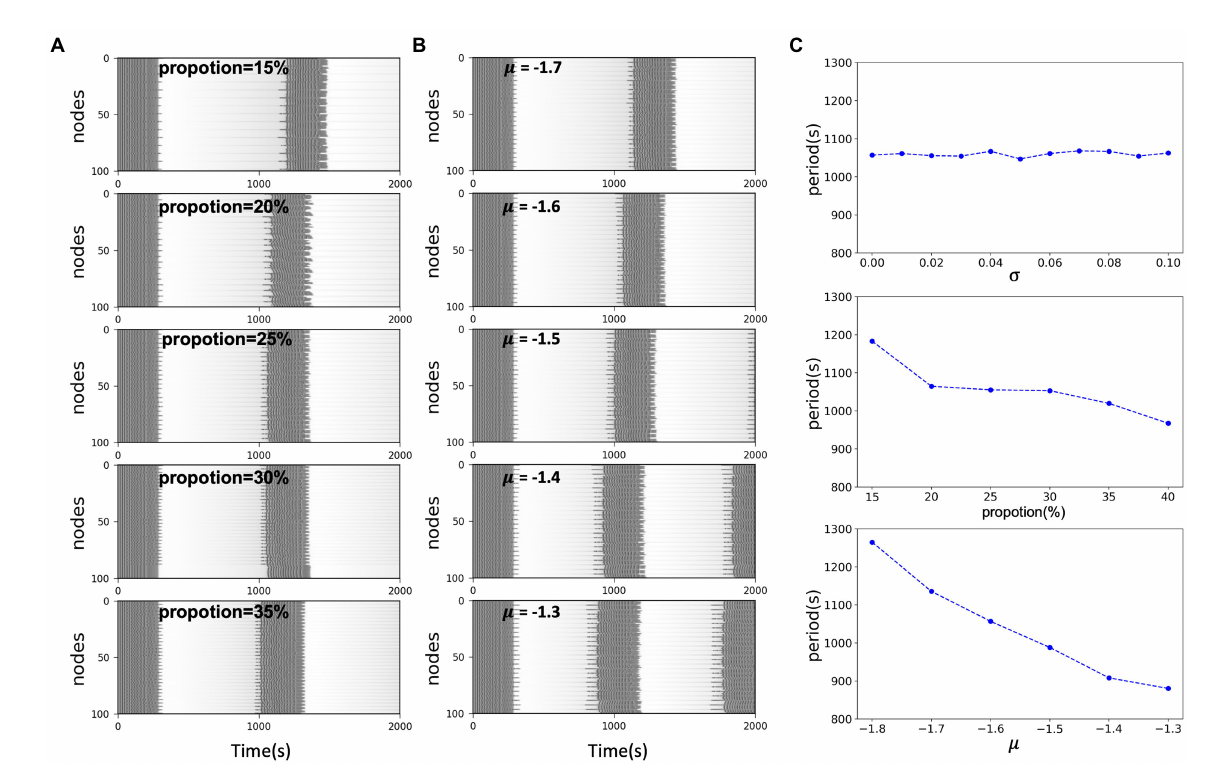
FIGURE 4 (A) Simulated time series of network model with different excitatory node proportions. In the same scale network, the larger the excitability proportion, the shorter the system oscillation period. (B) Simulated time series of network model with the same proportion and different excitability level μ . In the same scale network, the closer the distance between x 0 and the threshold, the shorter the oscillation period of the system. (C) System oscillation period curve with respect to the excitability heterogeneity of network nodes, network size and the network excitability level, respectively.